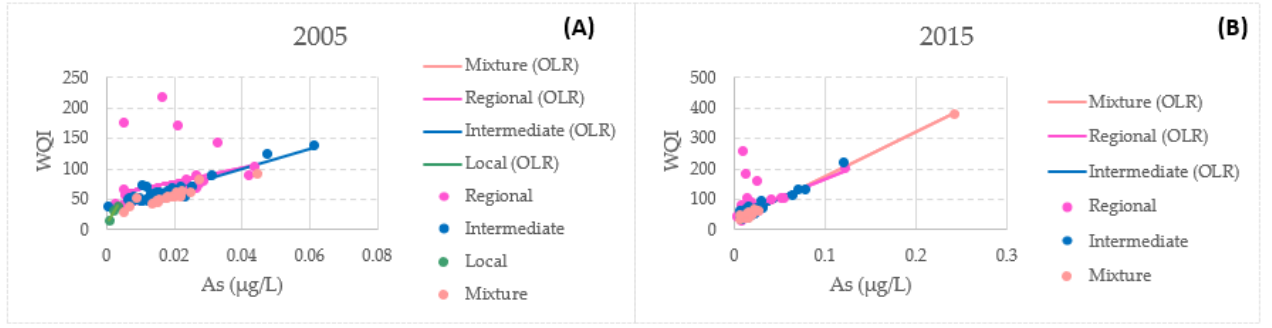
Figure 13. Uncertainty weighted least-squares linear regression (arsenic and fluor) for the different flow systems: ( A ) 2005 and ( B ) 2015.